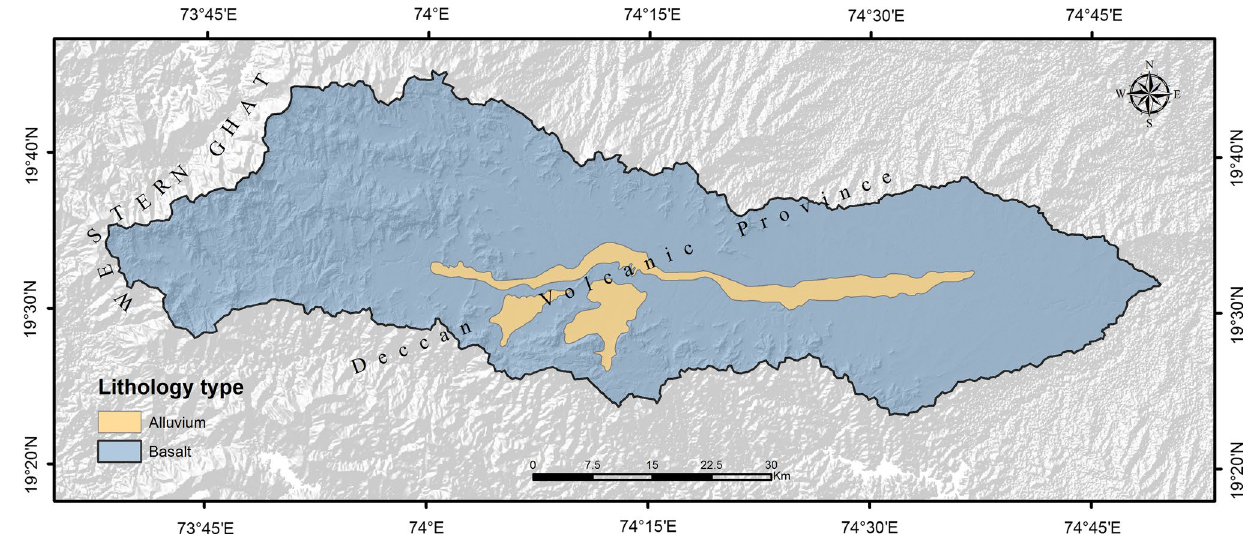
Fig. 4 Lithology map of the study area